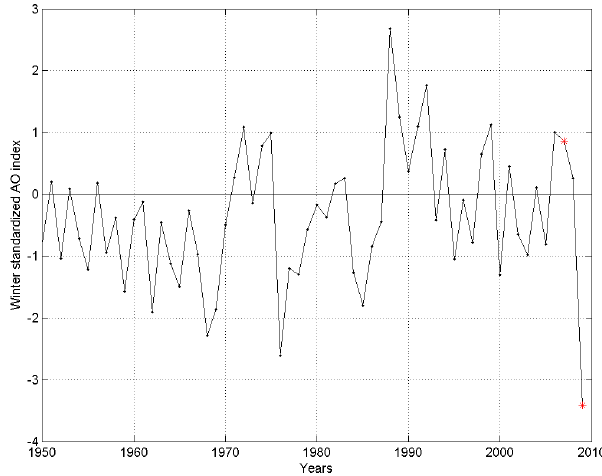
Fig. 1. Time series of the AO index, averaged for December through Figure 1: February, for the period 1950–2010, normalized by the standard de- Time series of the AO index, averaged for December through February, for the period 1950- viation of the monthly AO index from 1979–2000. Data were ob- 2010, normalized by the standard deviation of the monthly AO index from 1979-2000. Data tained at www.ncep.noaa.gov/. Years 2008 and 2010 are indicated Data were obtained at www.ncep.noaa.gov/. Years 2008 and 2010 are indicated in red. in